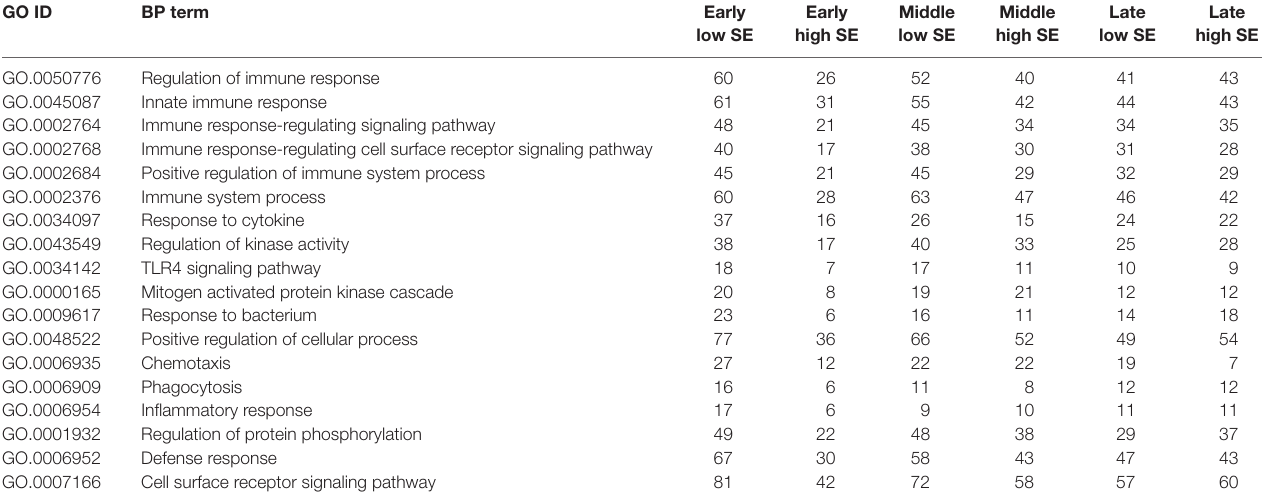
TaBle 1 | Gene ontology (GO) biological process (BPs) terms identified using the peptide array and the number of differentially phosphorylated peptides associated with high and low loads of Salmonella Enteritidis colonization. gO iD BP term